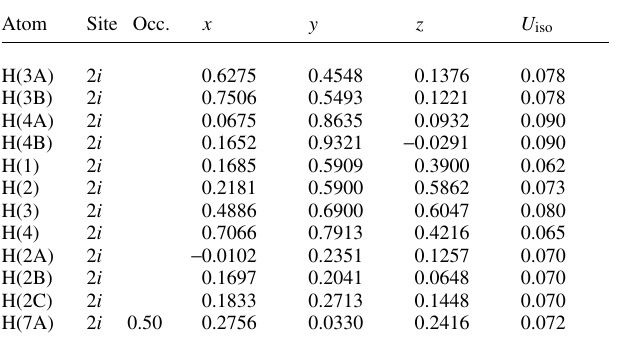
Table 2. Atomic coordinates and displacement parameters (in Å 2 )